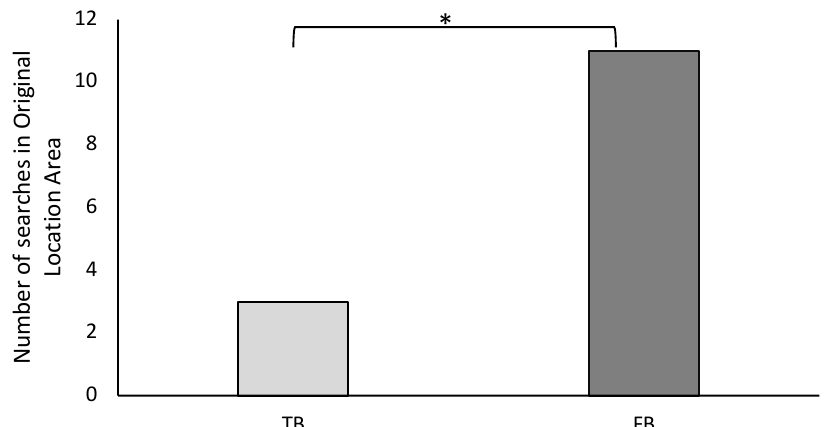
Dichotomous Search Bias Results for Experiment 1